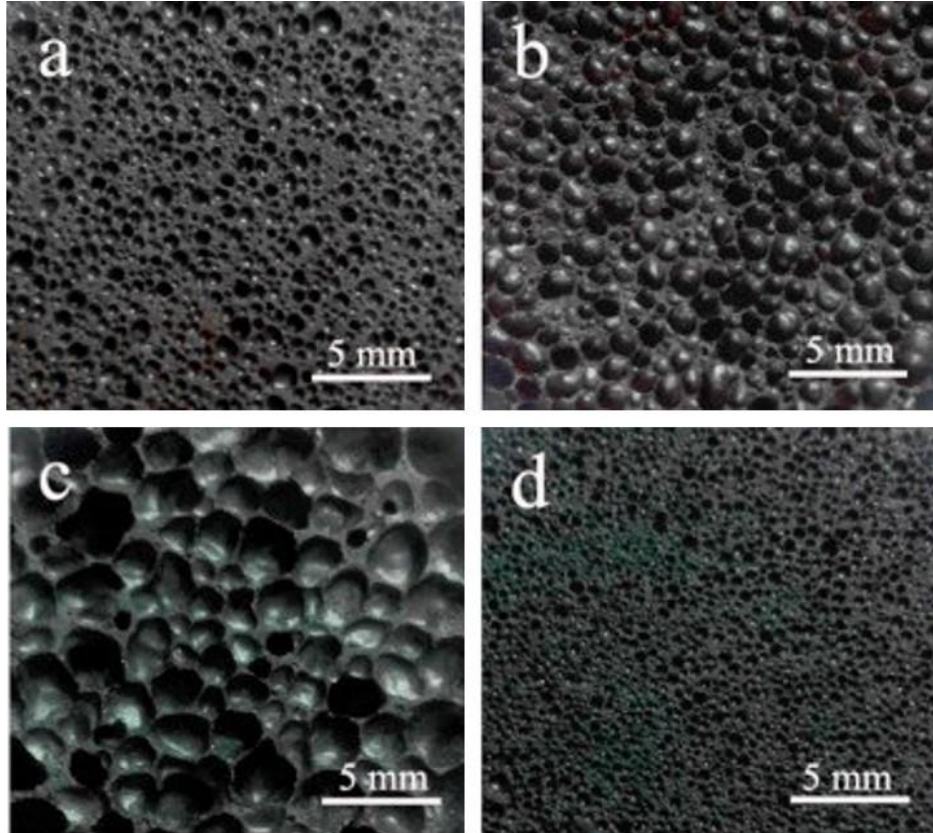
Figure 11. SEM photos of ceramics with different contents of lead – zinc tailings [124]: ( a ) 6 wt.%; ( b ) 12 wt.%; ( c ) 18 wt.%; ( d ) 24 wt.%.